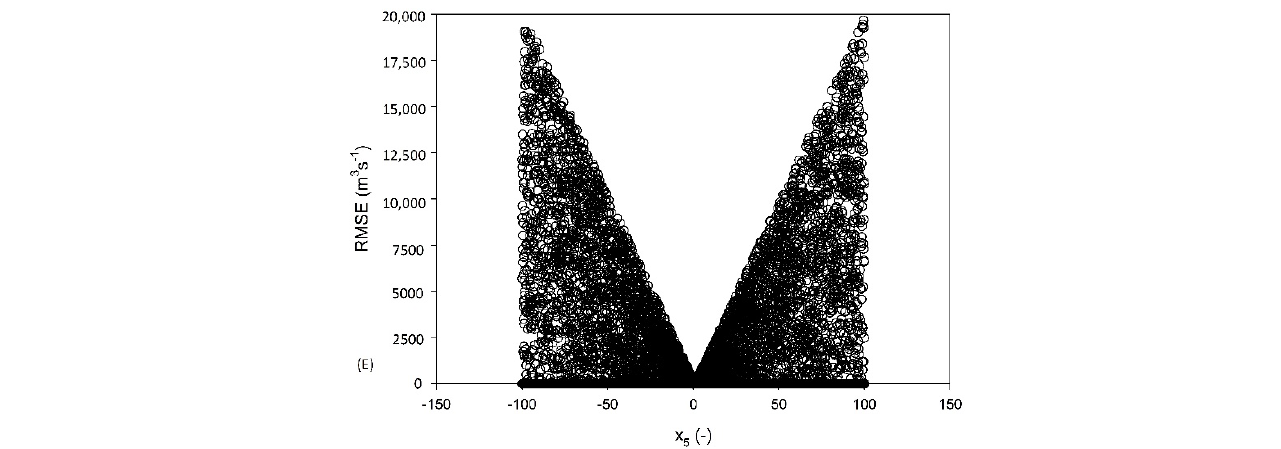
Figure A2. Scatter plots between the RMSE efficiency statistic ( Y -axis) and the parameter values: ( A ) X 1 , ( B ) X 2 , ( C ) X 3 , ( D ) X 4 and ( E ) X 5 , for the GR5J hydrological model.